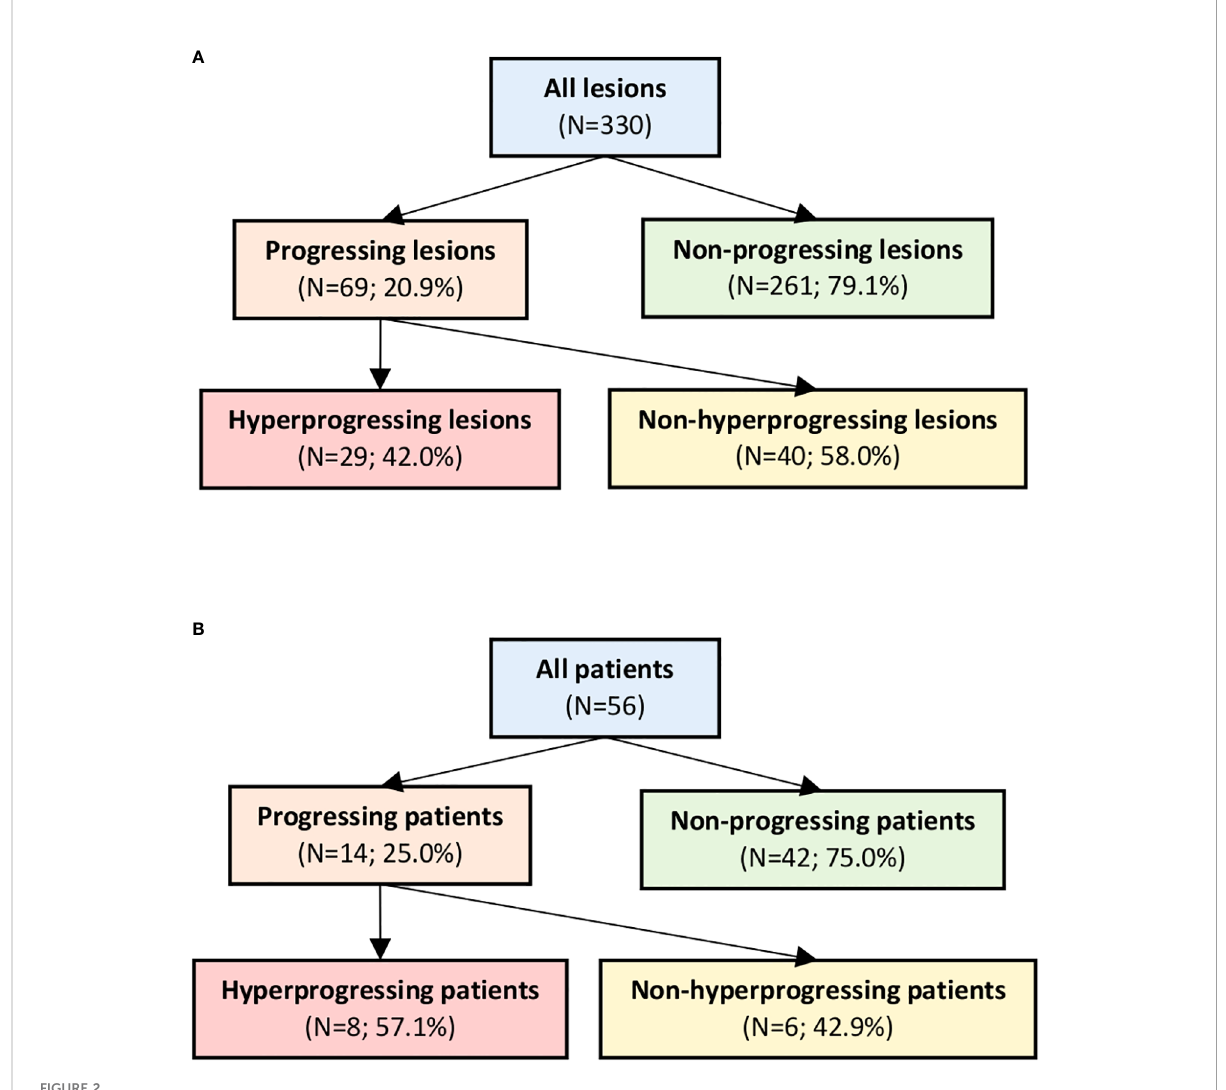
FIGURE 2 Progression and hyperprogression rates on a lesion (A) and a patient level (B)